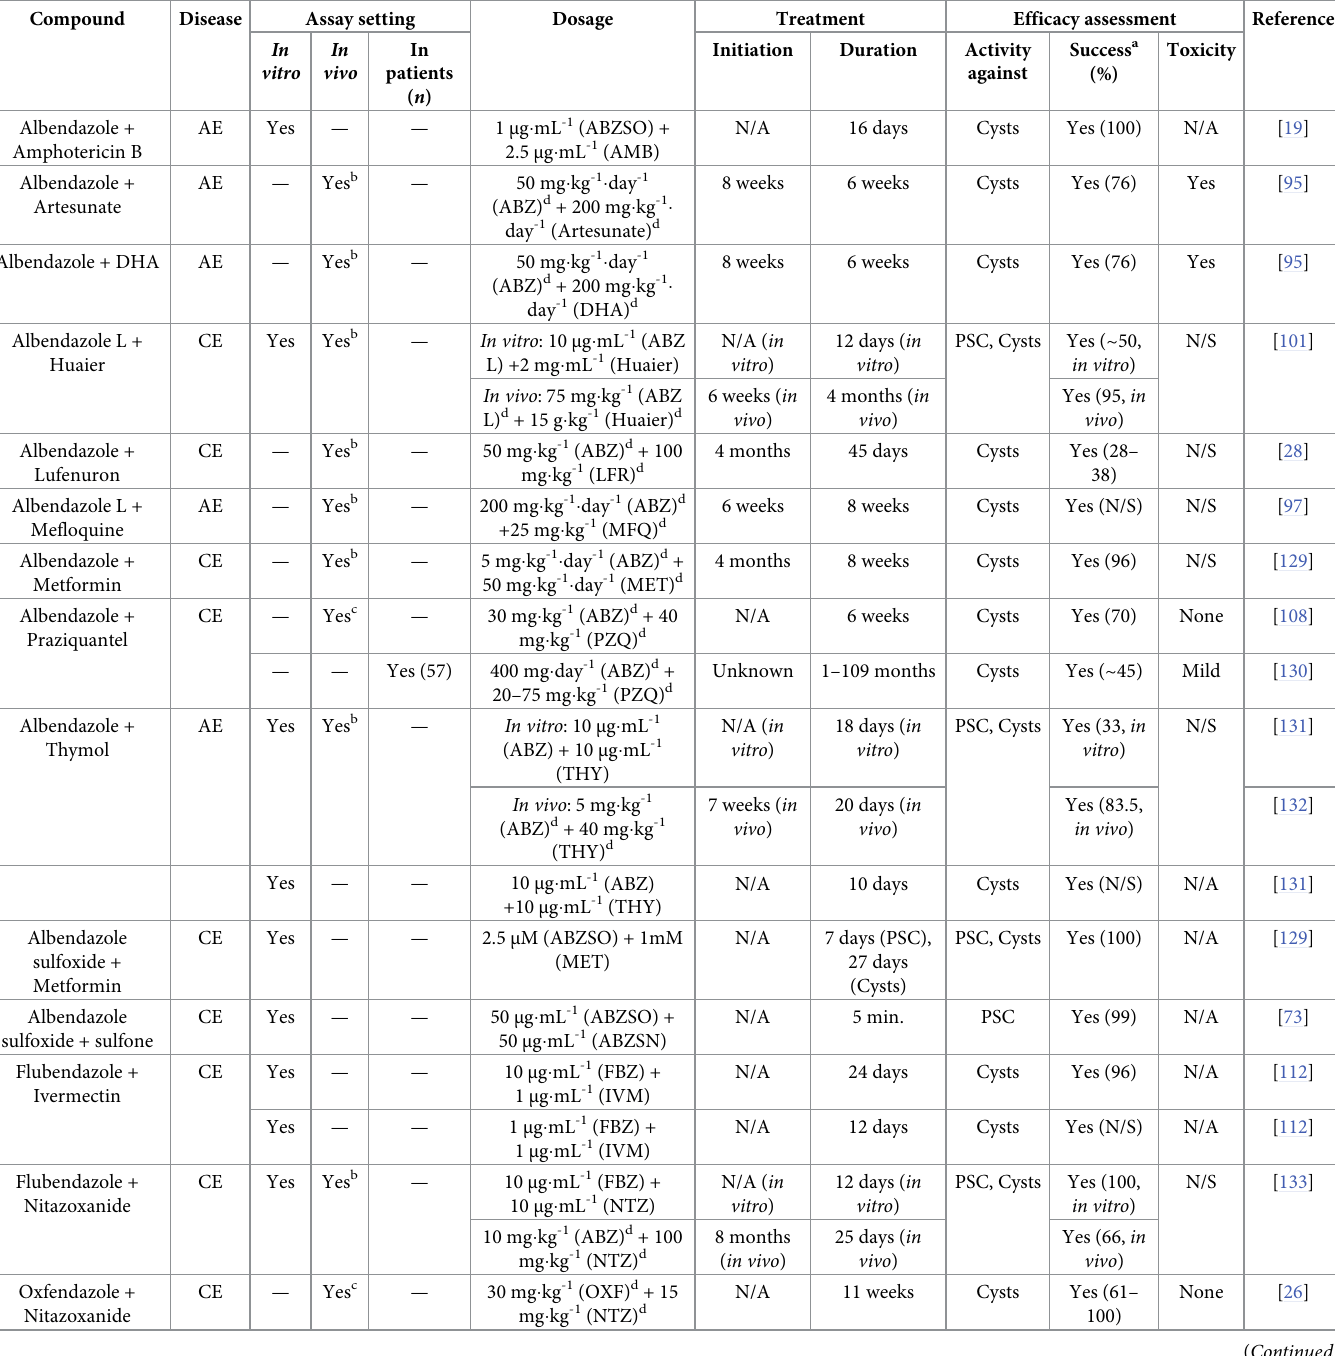
Table 2. Characteristics of benzimidazole compounds, including their metabolites and solubility-improved formulations, in combination with other drugs for the treatment of human cystic and alveolar echinococcosis based on the published literature from 2008 to